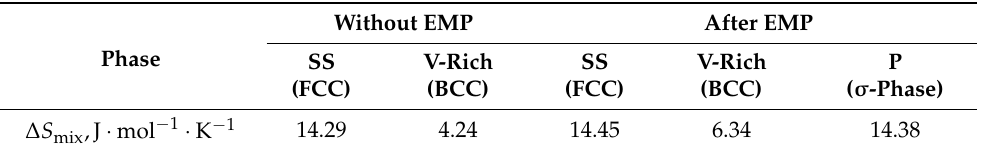
Table 2. The calculated entropy of mixing for each phase in the investigated Al 0.25 CoCrFeNiV HEA (see Figure 5). Without EMP After EMP Phase